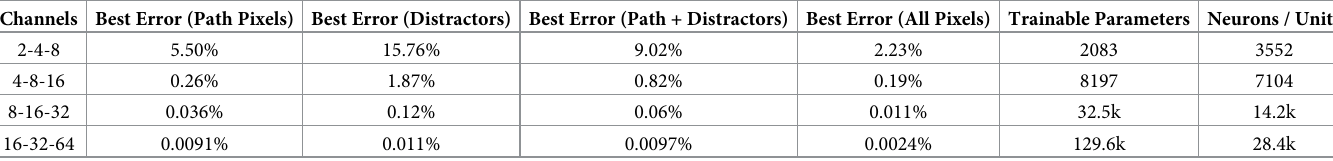
Table 1. U-Net Model Performance. We trained four U-Net architectures of increasing size by each time doubling the number of channels in each layer. For each model, we report the best performance across 10 trained models on 10,240 test samples.